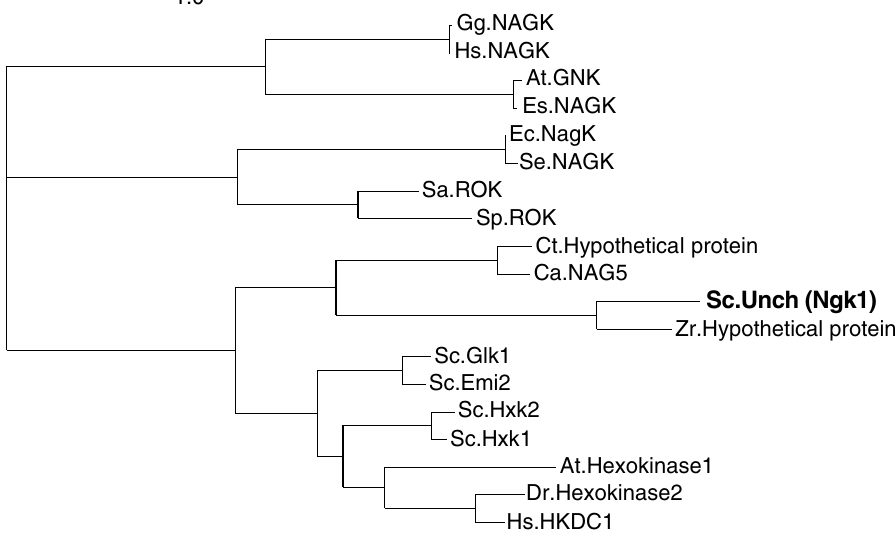
Figure 6. Phylogenic analysis of Ngk1 with GlcNAc kinases and hexokinases. Phylogenic tree of identified or putative GlcNAc kinases and hexokinases. A phylogenetic tree was created using Clustal Omega 19 and visualized with Dendroscope 3 20 . Ngk1 and hexokinases of S. cerevisiae : Sc.Unch (Ngk1) (AAT92658.1), Sc.Hxk1 (NP_116711.3), Sc.Hxk2 (NP_011261.1), Sc.Glk1 (NP_009890.1), Sc.Emi2 (NP_010804.3). GlcNAc kinases of C. albicans (Ca.NAG5, BAB43816.1), human (Hs.NAGK, EAW99780.1), E. coli